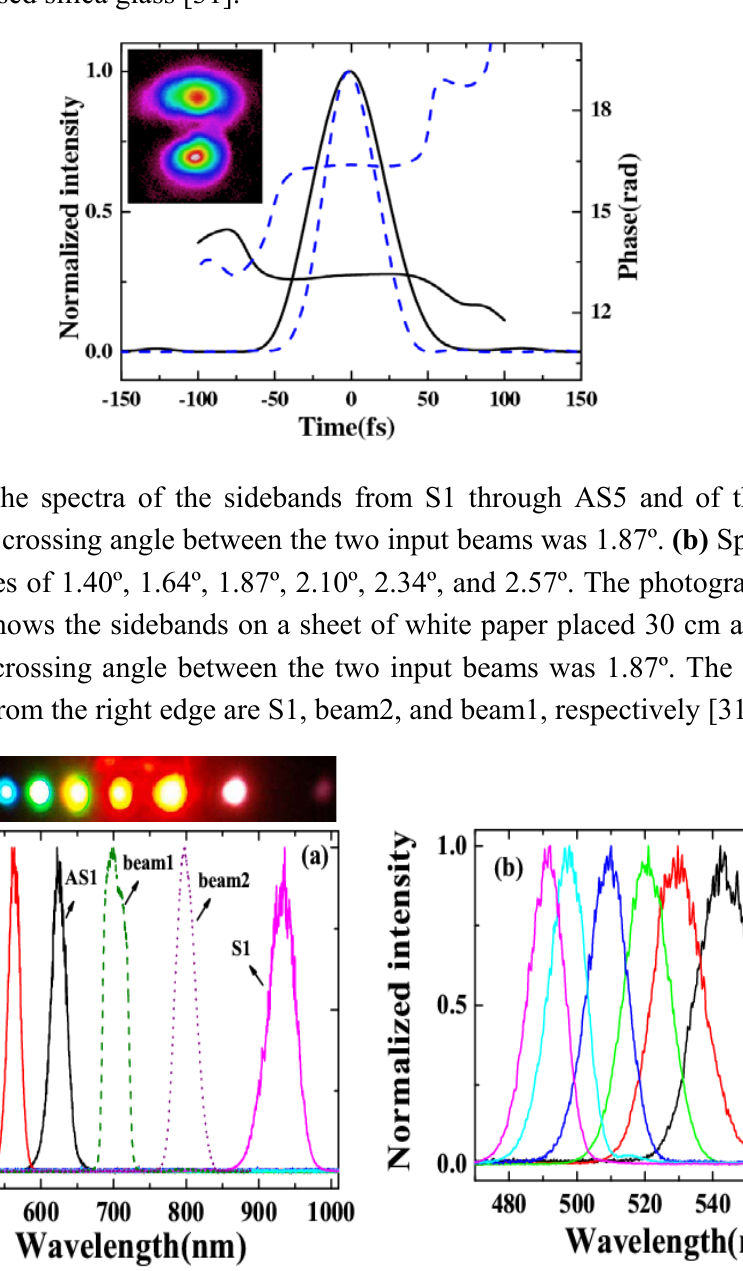
Figure 7. The temporal profile and phase of beam1 (dashed lines) and of beam2 (solid lines). The inset patterns are the spatial pattern beam1 (lower) and beam2 (upper) on the surface of the fused silica glass